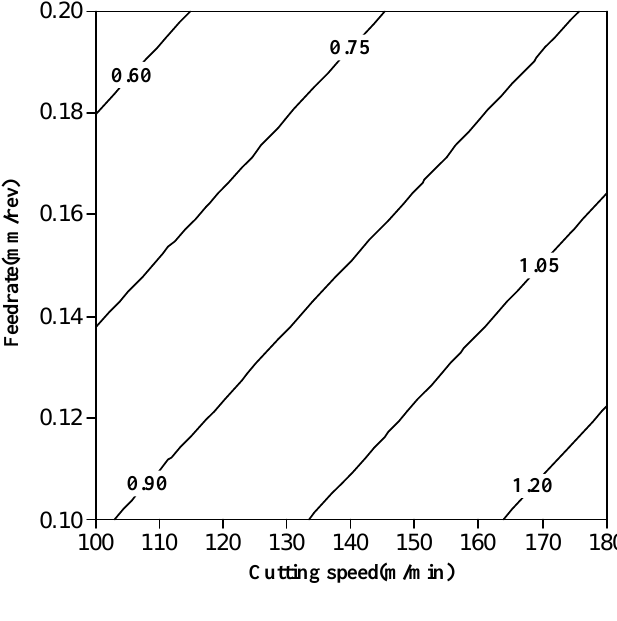
Figure 3. Feed rate versus cutting speed contour plotted for first-order